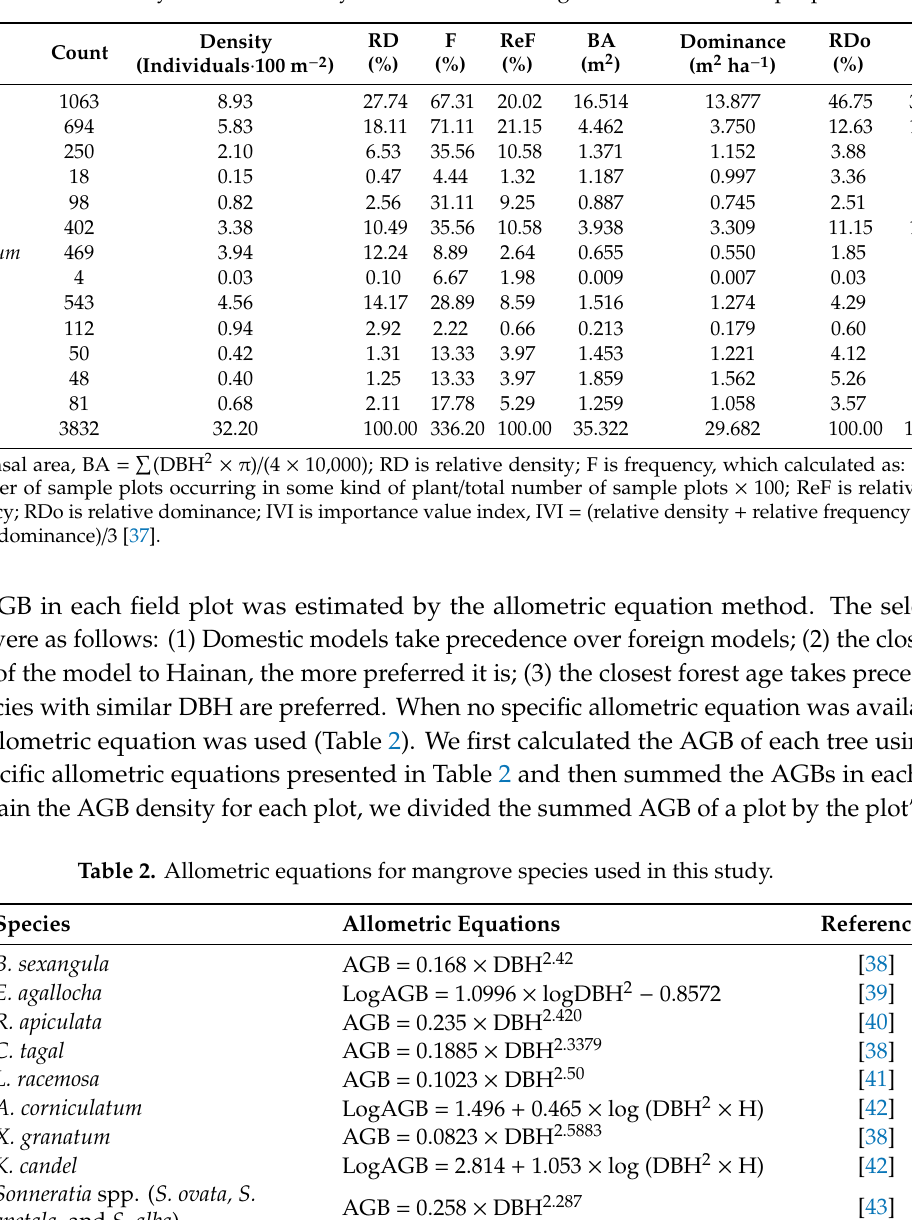
Table 1. Summary of the community structure of the mangrove forest in 45 sample plots.